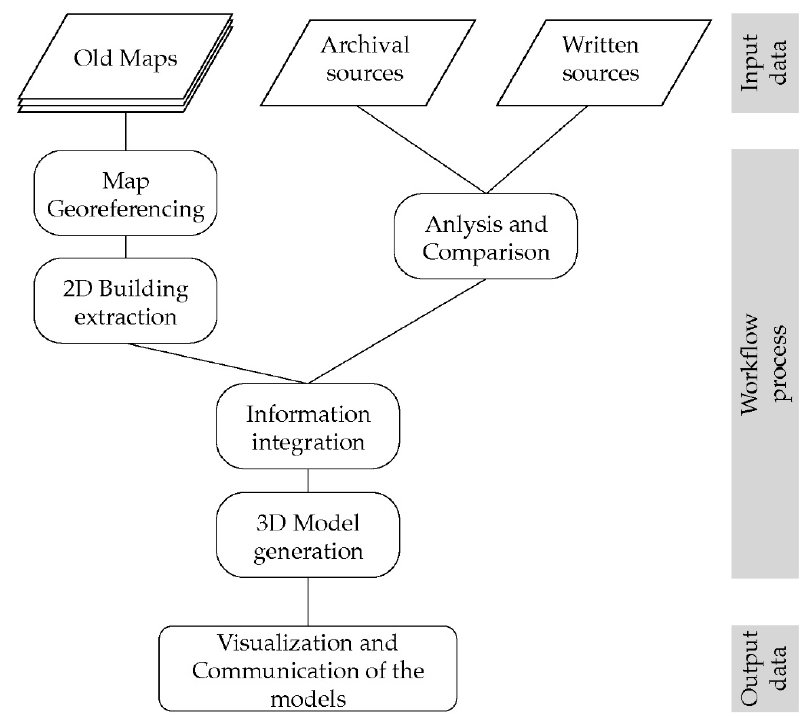
Figure 1. Methodology and workflow adopted to generate the historical city model integrating data from 2D historical maps and other sources.